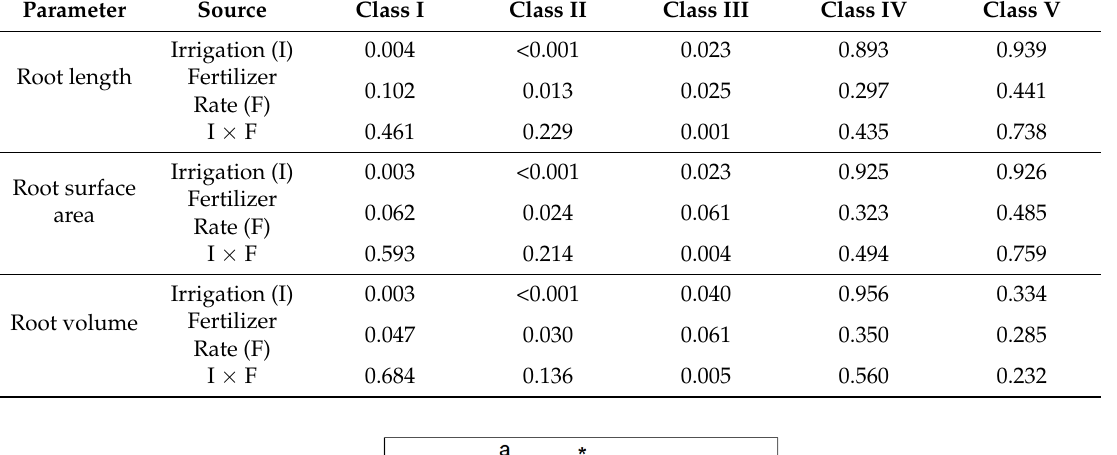
Table 3. p -values for main effect of fertilizer rate and irrigation and their interaction on root length surface area and volume of different class.